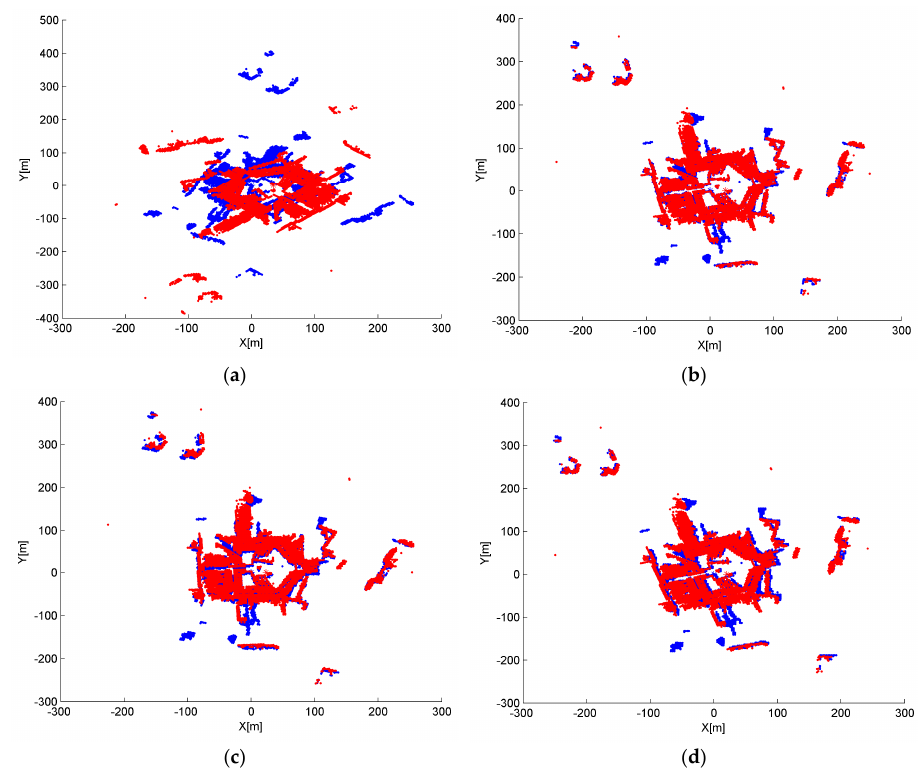
Figure 11. Nadir view of the spatial distributions after IME when: ( a ) t G = 2.5 m; ( b ) t G = 5 m; ( c ) t G = 10 m; and ( d ) t G = 20 m and d G is fixed to 2.5 m.